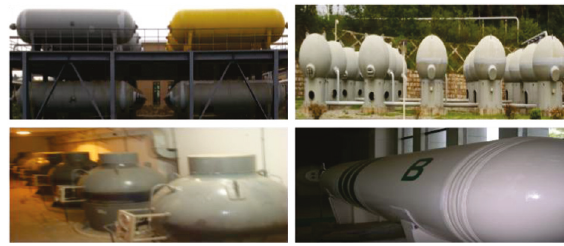
Figure 1: Pneumatic pressure equipment.